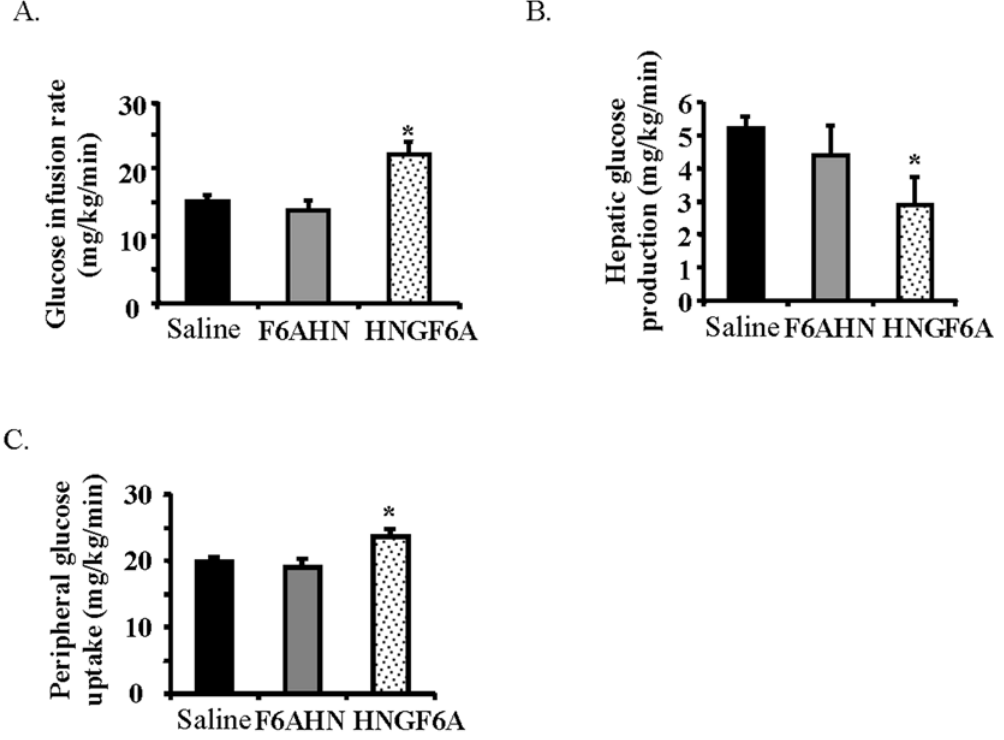
Figure 5. Effects of peripheral administration of the potent HN analog, HNGF6A, on glucose metabolism. Effect of IV saline, F6AHN and HNGF6A ( n =6 each) on A) GIR, B) HGP, and C) glucose uptake. Values are means 6 SE. *Significantly different from other experimental groups, P , 0.05.